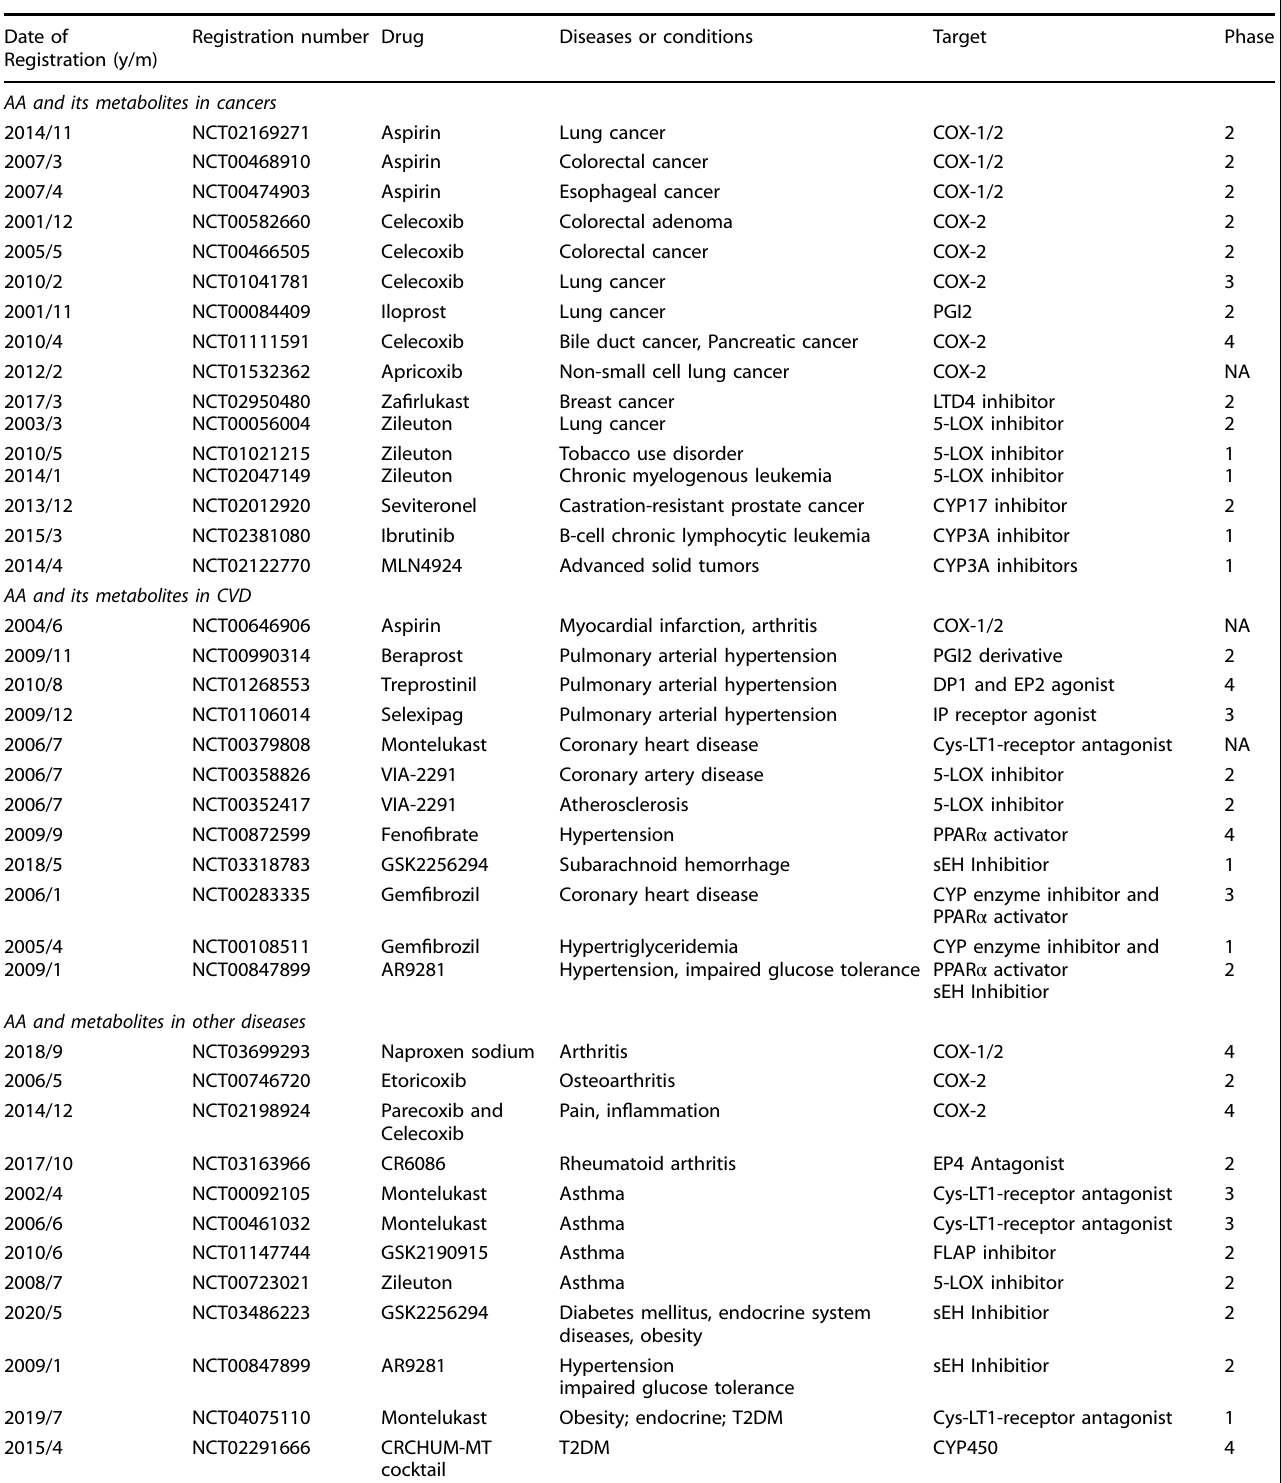
Table 4. Clinical trials associated with AA and its metabolites in different diseases or